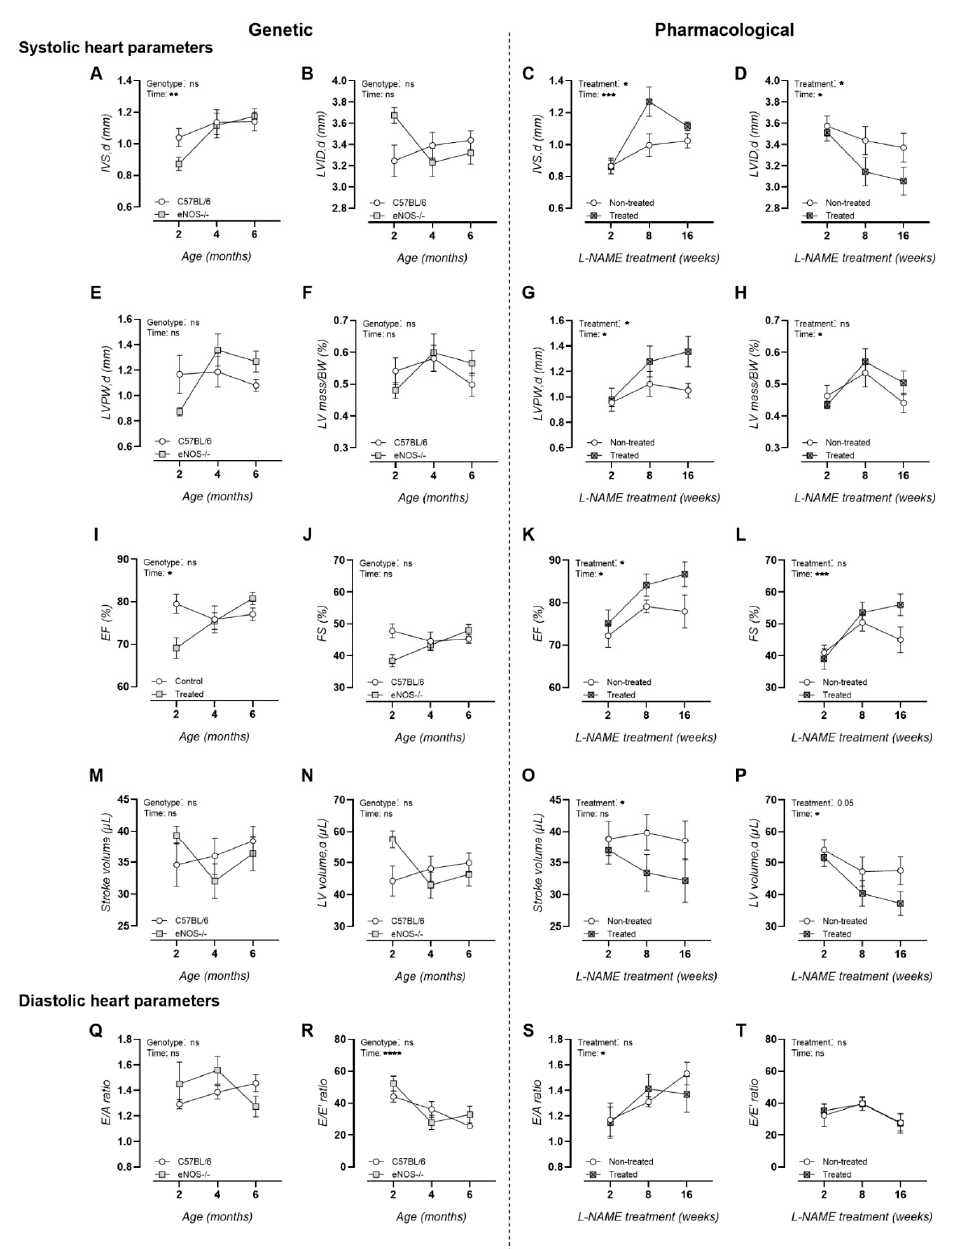
Figure 1. Systolic and diastolic echocardiographic heart function analysis of studied murine models. Results of the genetic NO dysfunction murine model are depicted in the left model and those of the pharmacologically induced NO dysfunction murine model in the right one. Systolic heart parameters: ( A , C ) IVS,d; ( B , D ) LVID,d; ( E , G ) LVPW,d; ( F , H ) LVmass/BW; ( I , K ) EF; ( J , L ) FS; ( M , O ) stroke volume; and ( N , P ) LV volume,d. Diastolic heart parameters: ( Q , S ) E/A and ( R , T ) E/E ′ . Factorial ANOVA for the factors genotype and treatment; * p < 0.05 , ** p < 0.02 , *** p < 0.002 , **** p < 0.0002. Data are presented as mean ± SEM. IVS,d = inner ventricular septum thickness during diastole; LVID,d = left ventricular inner diameter during diastole; LVPW,d = left ventricular posterior wall thickness during diastole; LV mass/BW = left ventricular mass corrected for body weight; EF = ejection fraction; FS = fractional shortening; E/A = peak velocity blood flow in early diastole ( E ) to peak velocity flow in late diastole ( A ); E/E ′ = mitral peak velocity of early filling ( E ) to early diastolic mitral annular velocity (E ′ ).